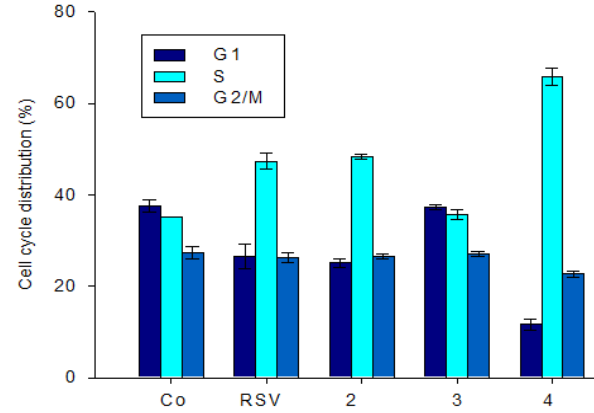
Figure 6. Influence of stilbene derivatives on the cell cycle phases of the SW480 cells line. Cells were grown for 48 h in the presence of 30 µM resveratrol (or no RSV in a control experiment) or 30 µM stilbene derivatives (numbered on the x-axis). After treatment, nuclear DNA was labeled with propidium iodide. The cell cycle effect of the tested compounds was done analysing cell distribution in the different phases of the cell cycle (mean ± standard deviation of two independent